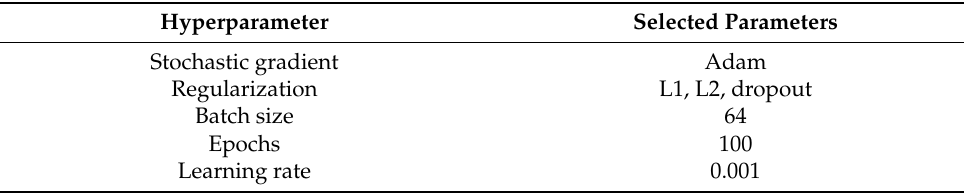
Table 2. Hyperparameter